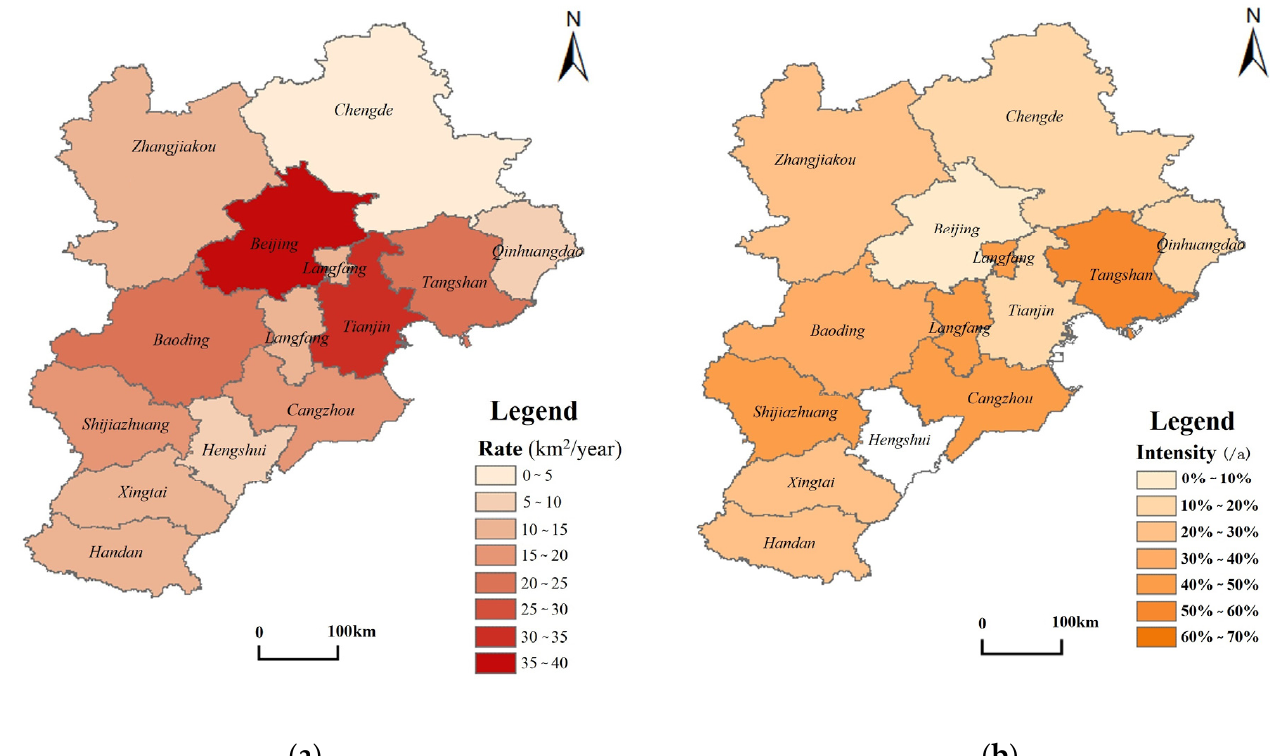
Figure 7. Expansion rate and intensity of different cities: ( a ) expansion rate; ( b ) expansion